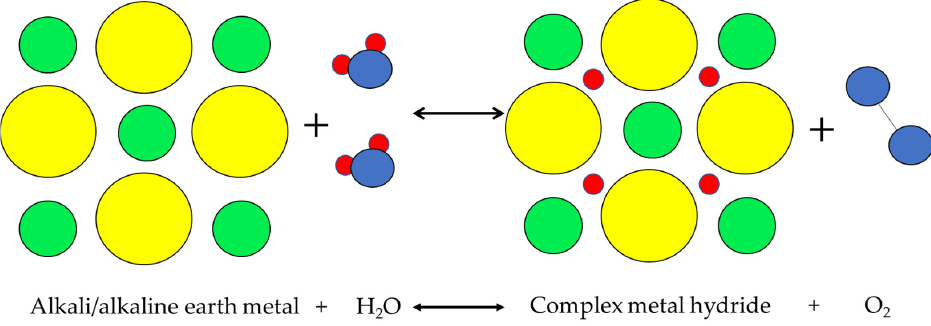
Figure 15. Alkalimetal+H 2 O physical process.